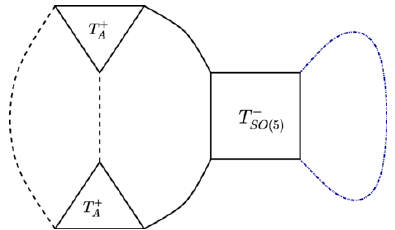
] so (5) u (1). The (cid:13)uxes are F =